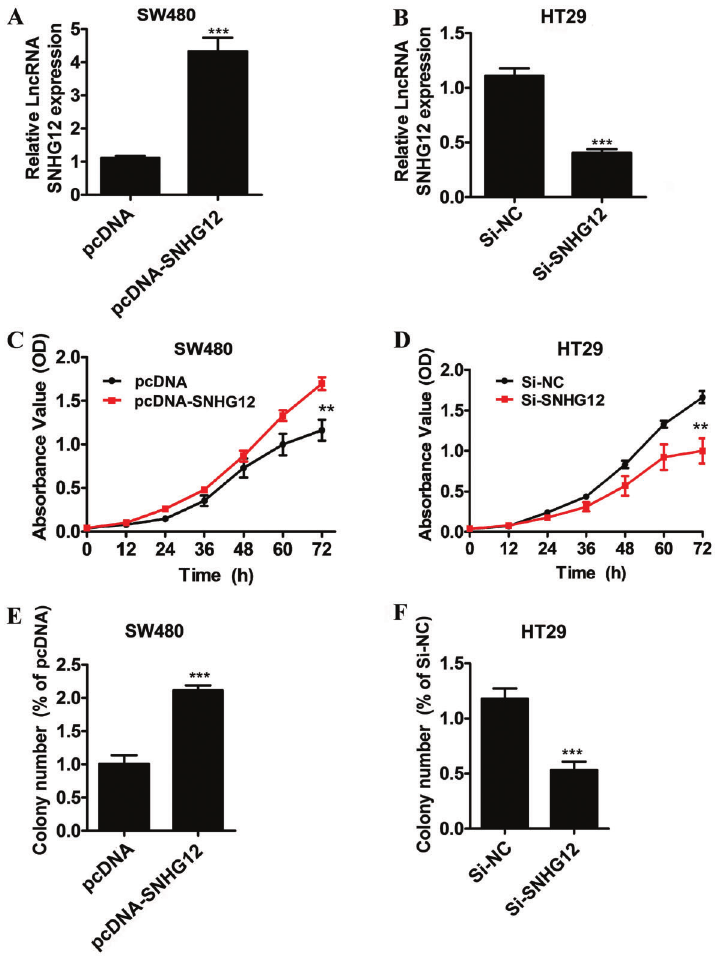
Figure 3. Effect of small nucleolar RNA host gene 12 ( SNHG12 ) on proliferation of colorectal cancer cells. The expression of SNHG12 was detected by qRT-PCR in SW480 cells transfected with pcDNA- SNHG12 ( A ) and in HT29 cells transfected with si- SNHG12 ( B ). MTT assay was performed to determine the proliferation of SW480 cells transfected with pcDNA- SNHG12 ( C ) and HT29 cells transfected with si- SNHG12 ( D ). Colony formation of SW480 cells transfected with pcDNA- SNHG12 ( E ) and HT29 cells transfected with si- SNHG12 ( F ). Data are reported as means ± SD. **P o 0.05 vs the control (Student ’ s t -test); ***P o 0.01 vs control (Student ’ s t